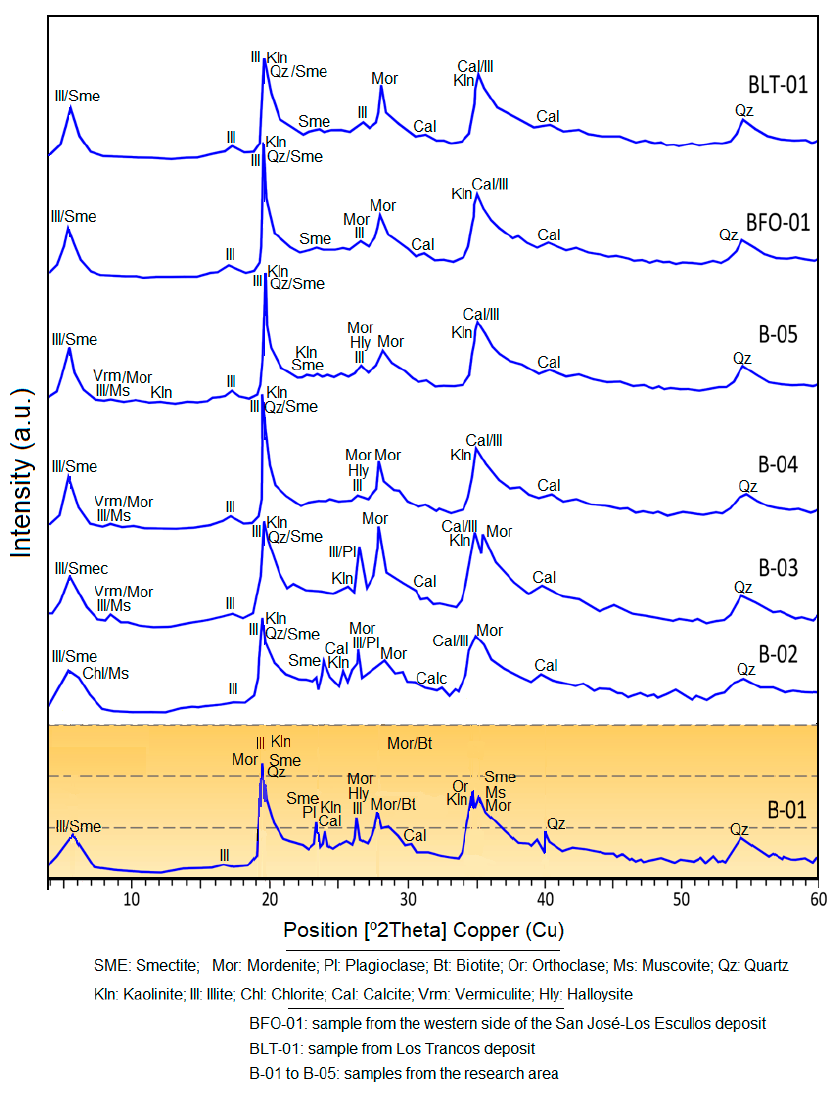
Figure 6. X-ray diffraction patterns of bentonite from the research area. The bentonisation and zeolitisation process in the south and southeast of Spain was